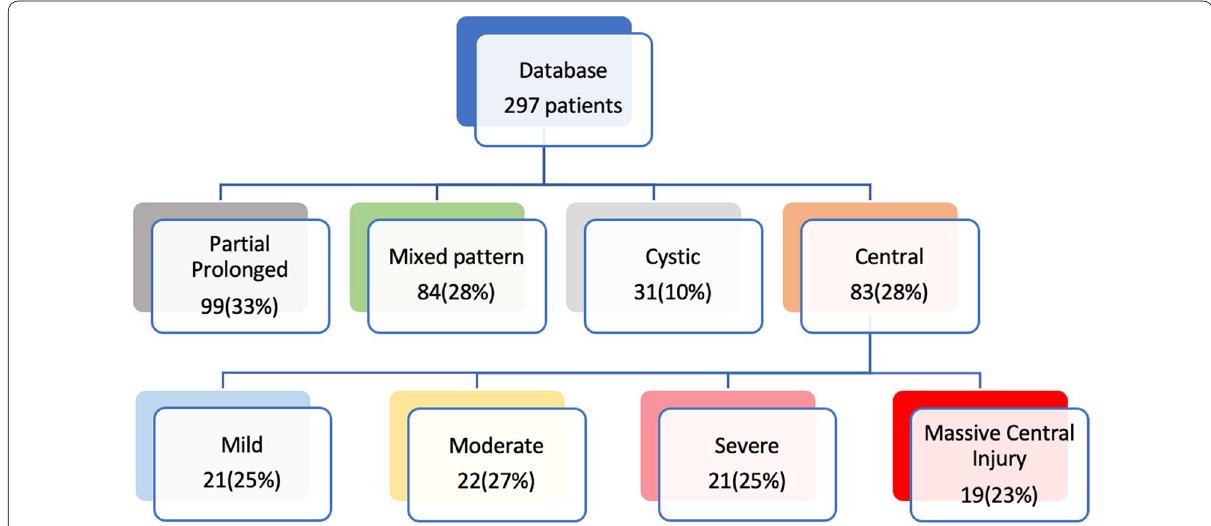
Fig. 1 Schematic diagram of the sequence of derivation of the individual subtypes from the sampled